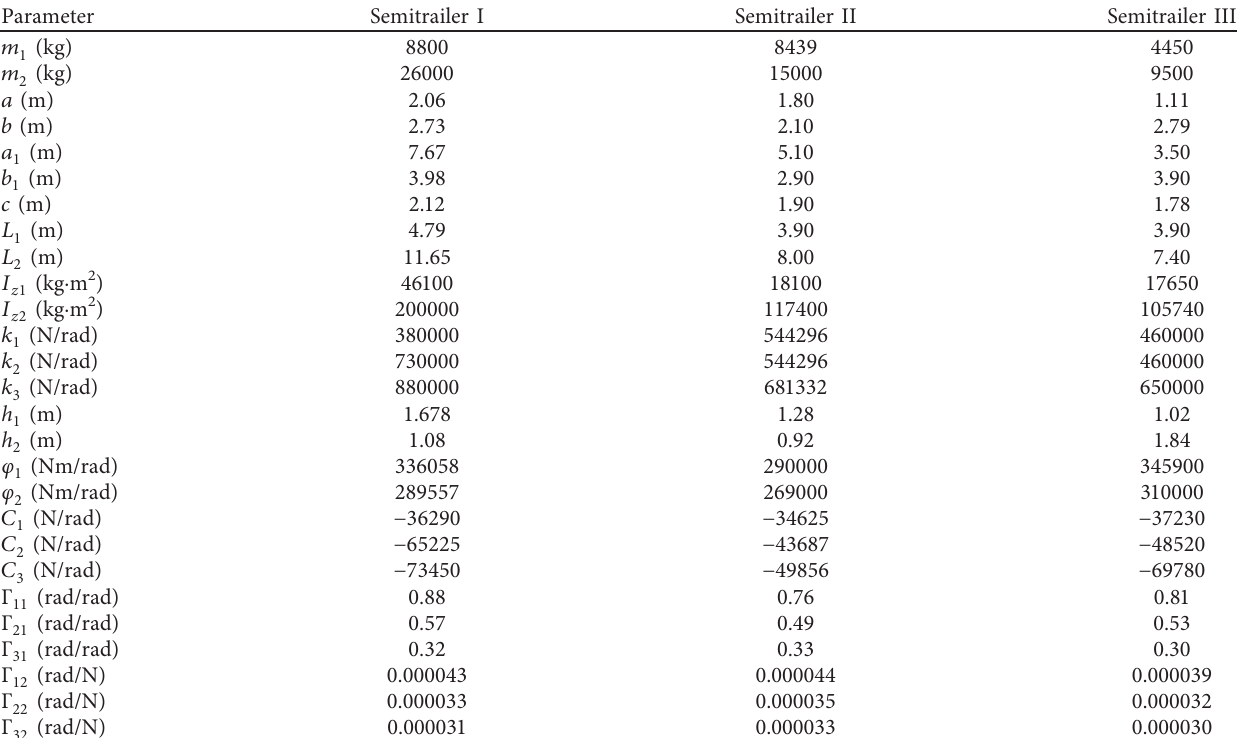
Table 1: Vehicle parameter and symbol